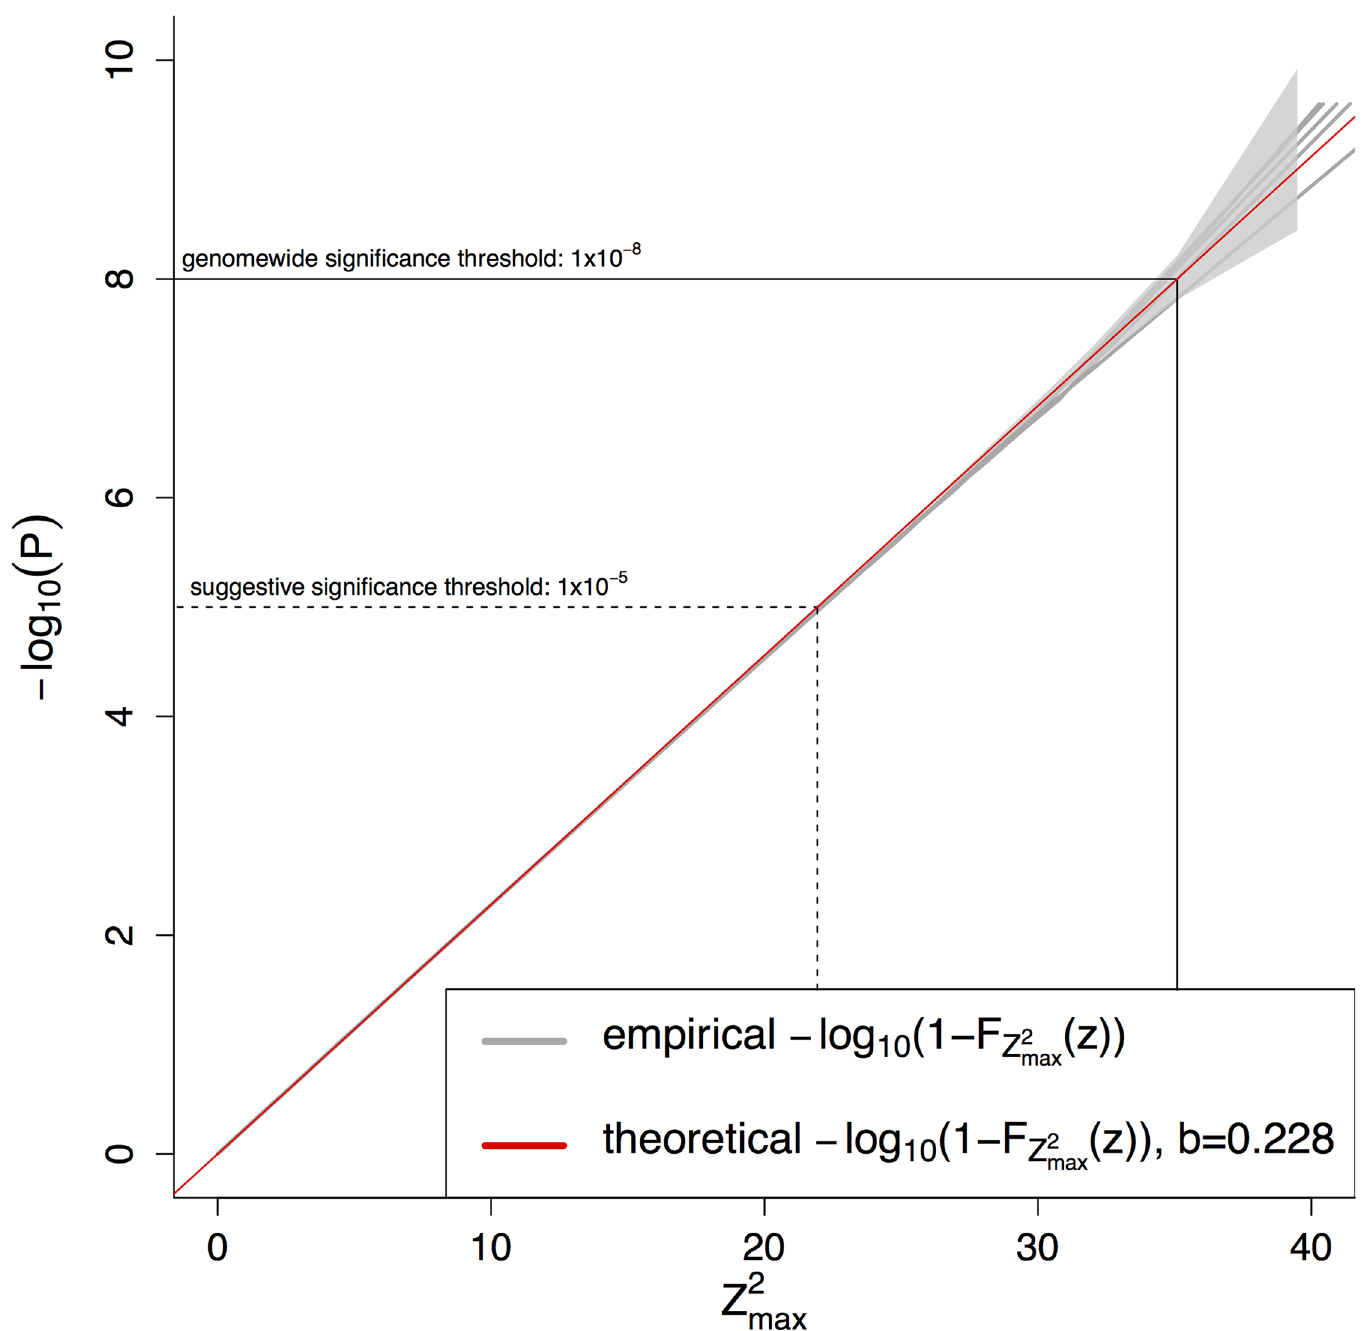
Fig 1. Five empirical evaluations of the − log 10 ( P )-distribution of the Z 2 max statistic, each obtained by simulating 2 × 10 9 replicates. The theoretical distribution was obtained by fi tting a straight line. The grey shaded area re fl ects the 95% Clopper-Pearson con fi dence interval [7].